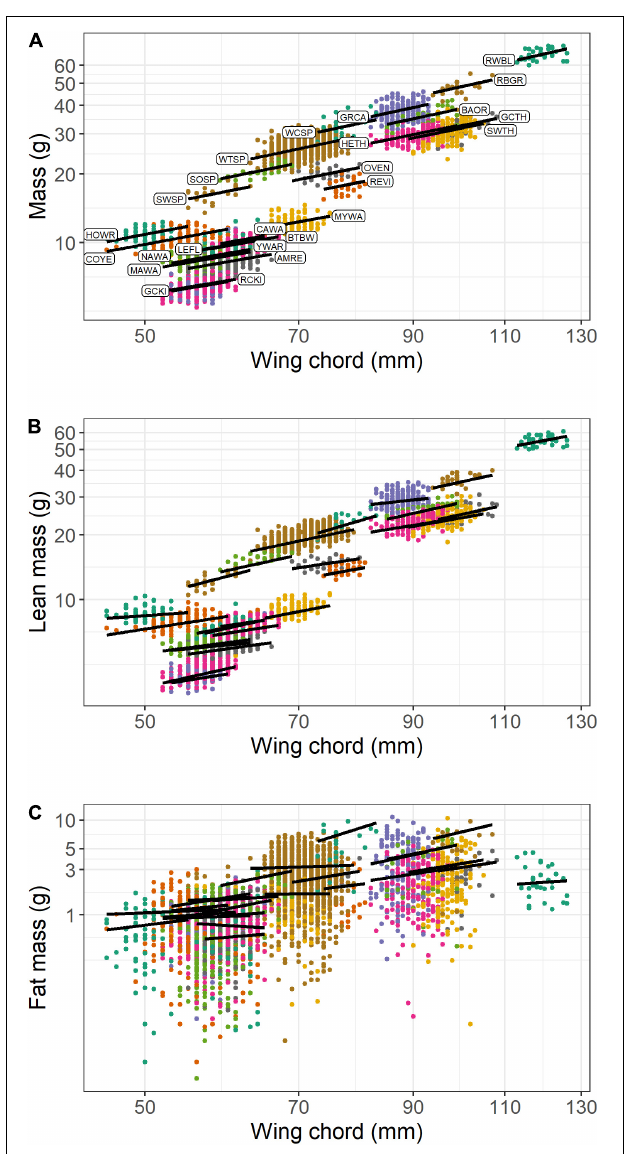
FIGURE 2 | Scaling of body mass (A) , lean mass (B) , and fat mass (C) with wing chord for 25 species of songbirds stopping over at Long Point, Ontario ( n = 3,549). The lines show the linear mixed model predictions when year = 2009 and season = spring. Species codes are shown in panel A and defined in Table 1 .